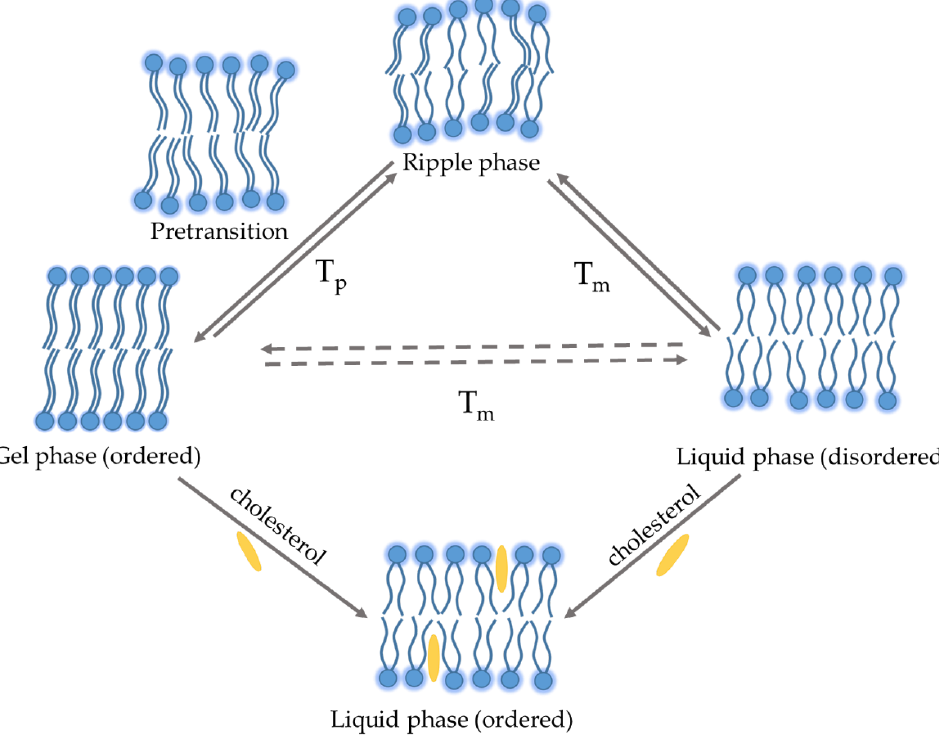
Figure 1. Thermotropic behavior of phospholipid bilayer in an aqueous medium. T p : pre-transition temperature, T m : phase transition temperature.